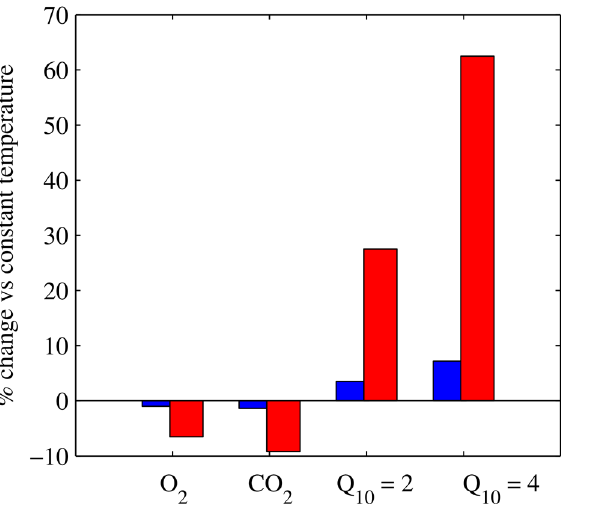
Fig 5. Estimated ecological and biogeochemical consequences of the diel surface temperature range. Potential bias in estimates of CO 2 and O 2 solubility and rates of processes with Q 10 values of 2 or 4 for a diel temperature range of 1 (blue) or 7°C